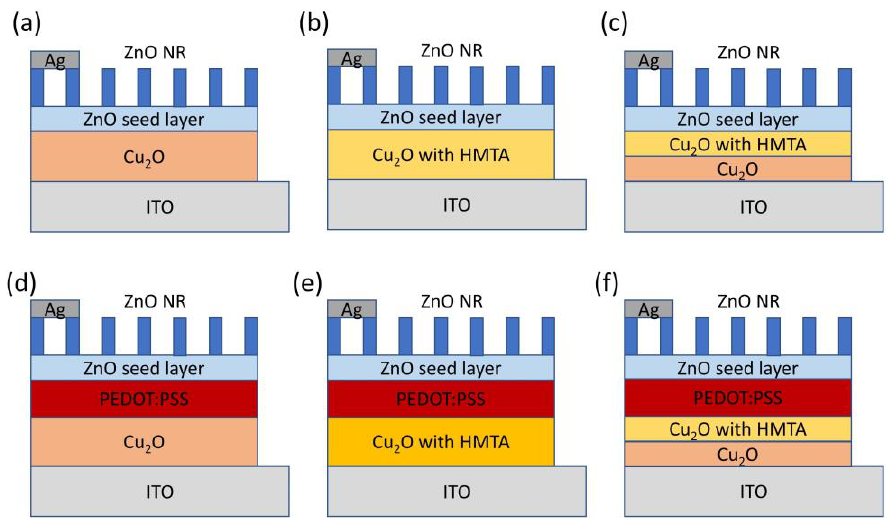
Figure 1. Schemes of six photoelectrochemical biosensors based on: ( a )–( c ) Cu 2 O/ZnO; ( d )–( f ) Cu 2 O/poly(3,4-ethylenedioxythiophene) polystyrene sulfonate (PEDOT:PSS)/ZnO heterostructure in this work.